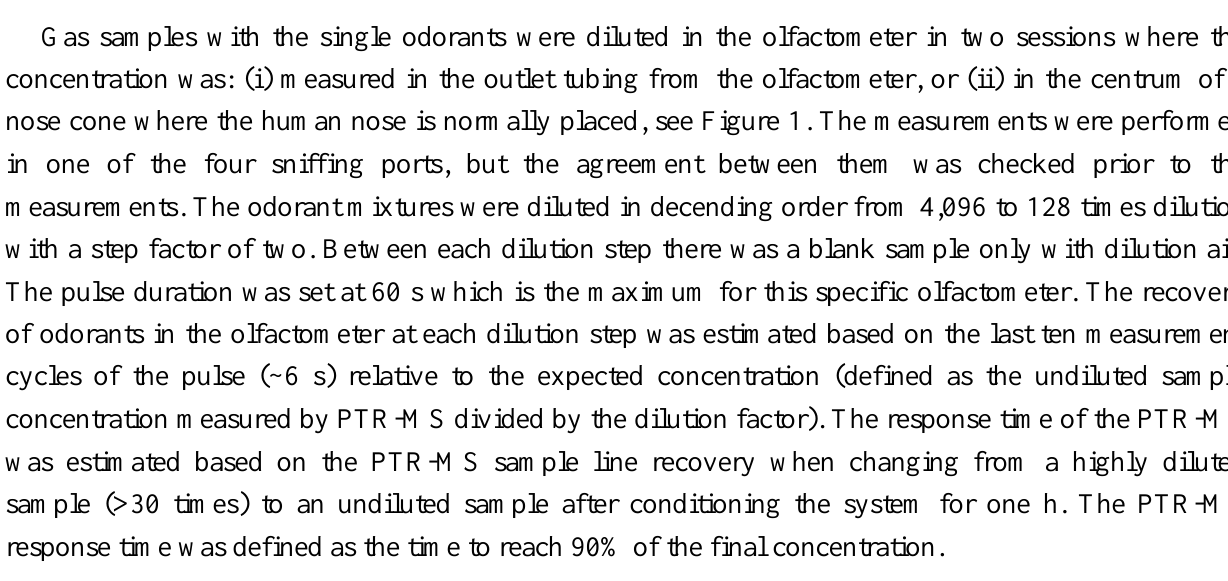
Figure 1. Schematic drawing of the experimental